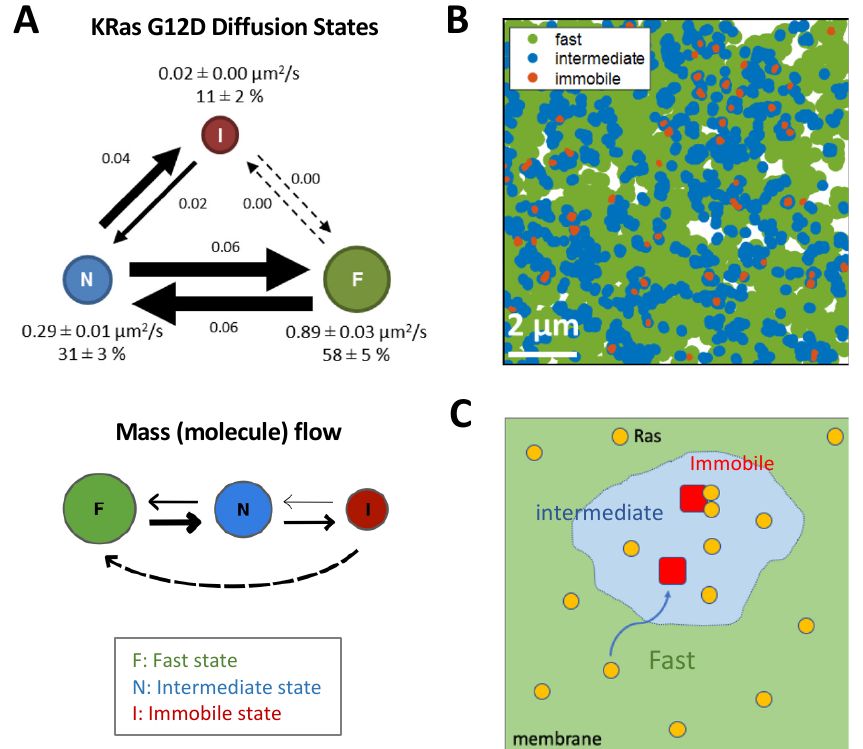
Figure 4. Ras diffusion on the membrane and localization to nanodomains. ( A ) KRas G12D molecules exhibit three diffusion states on the cell membrane, a fast (F) state, an intermediate (N) state, and an immobile (I) state, with state transitions between the F:N and N:I states but not F:I states. Analysis of this model suggests a net flow of Ras molecules from F to N to I states, and KRas is internalized while in the I state and recycled back to the membrane in regions that support the F state. ( B ) Mapping the locations of the three diffusion states revealed a nested organization of the membrane domains that confers each state, with each nanodomain that entraps Ras (immobile, red) living inside another, intermediate domain (blue), whereas most the membrane supports fast and free diffusion (green) of Ras. ( C ) Model depicting how Ras (yellow circles) diffuses on the membrane, frequently encountering the intermediate domains (light blue) and occasionally trapped in structures (red) within the latter, where they presumably form dimers and nanoclusters. ( A , B ) adapted from [130].